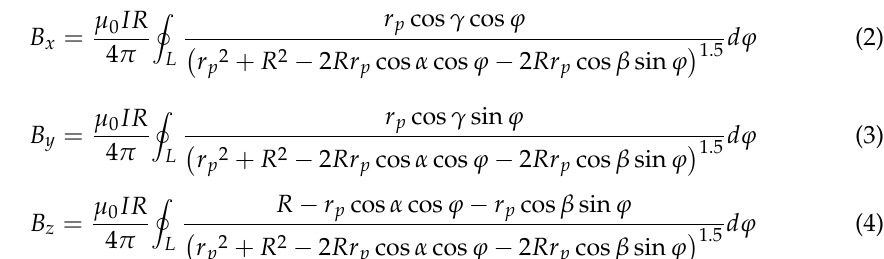
obtained by Equations